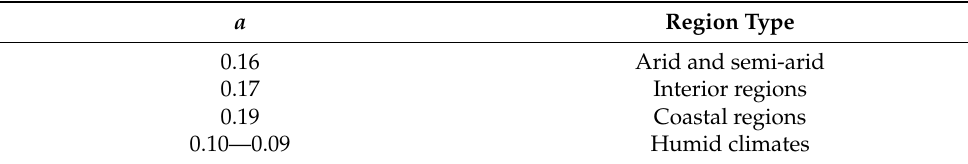
Table 3. Hargreaves and Samani’s empirical